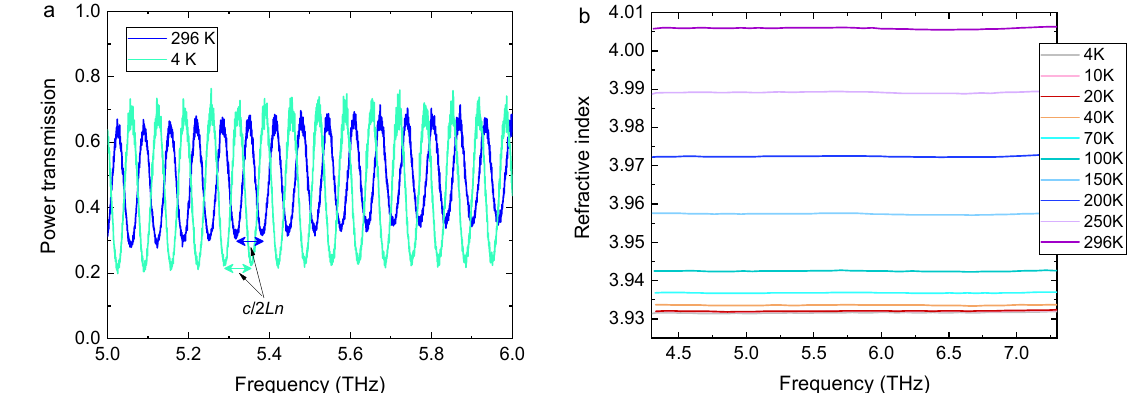
Figure 1. ( a ) Part of the transmission spectrum of Ge at 4 K and 296 K, showing Fabry–Perot fringes used in calculating the refractive index. ( b ) Calculated refractive index of Ge at different temperatures.